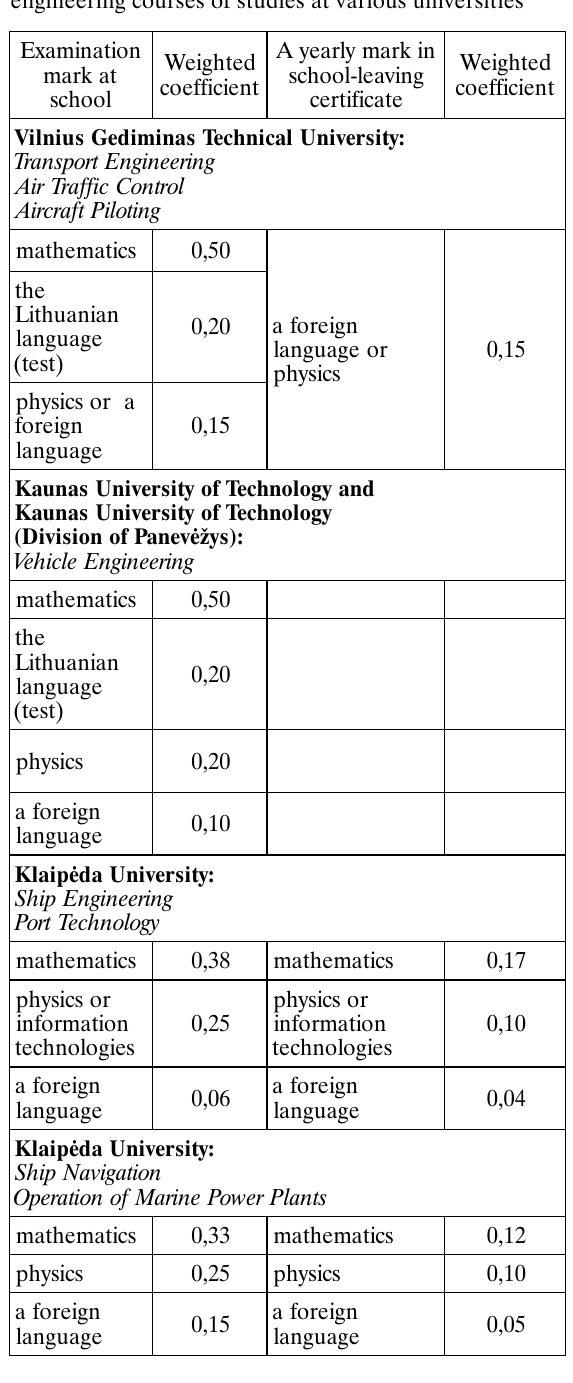
Table 3. Competitive marks of applicants to